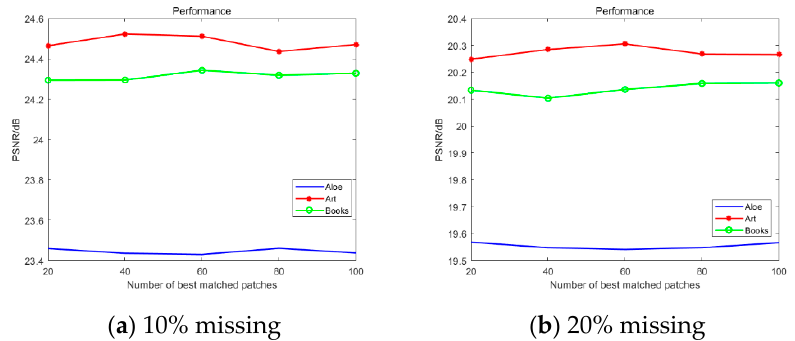
Figure 6. Performance comparison with best-matched patches.